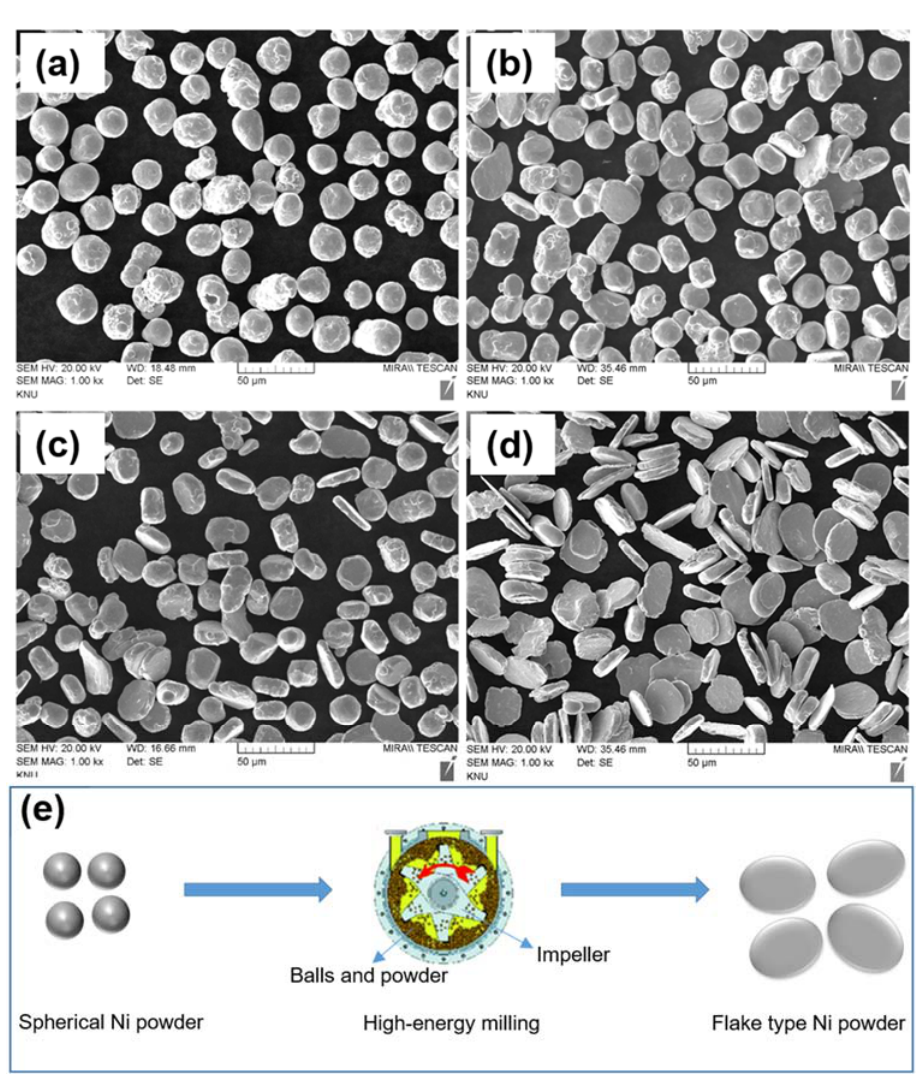
Figure 2. Scanning electron microscopy images of ( a ) pristine Ni powder; Ni powder milled for 30 min at a rotation speed of ( b ) 500 rpm, ( c ) 700 rpm, ( d ) 1000 rpm, and ( e ) the schematic illustration of the synthesis of the flake ‐ type Ni powder.